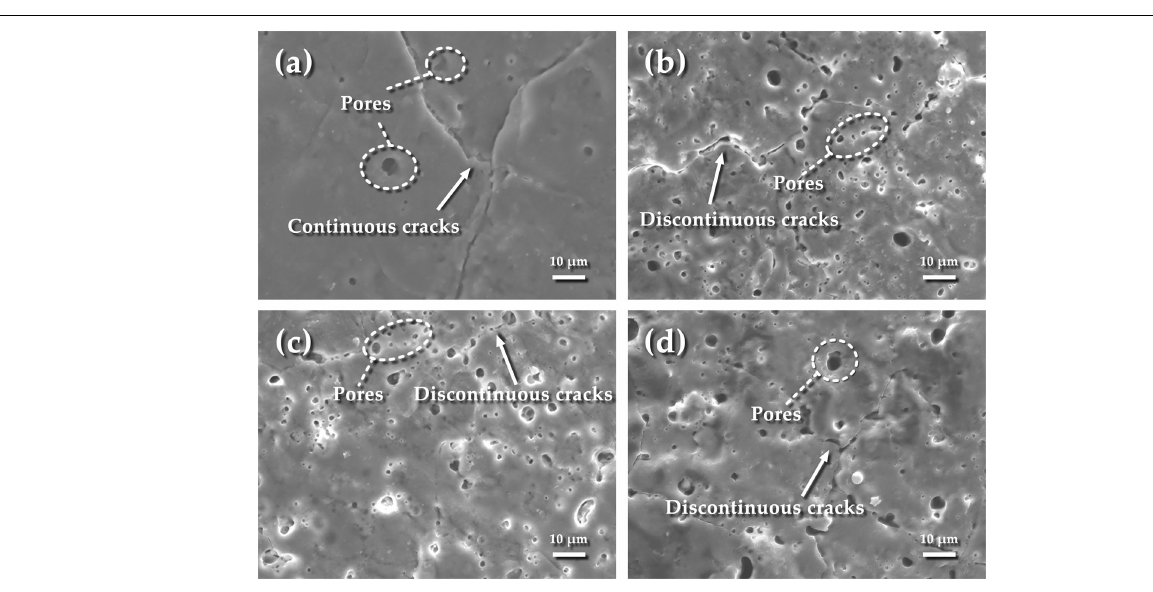
FIGURE 3 | Surface morphologies of coatings under different current modes: (a) 1.2 A; (b) 1.2–0.6 A; (c) 1.2–0.8 A; (d) 1.2–1.0